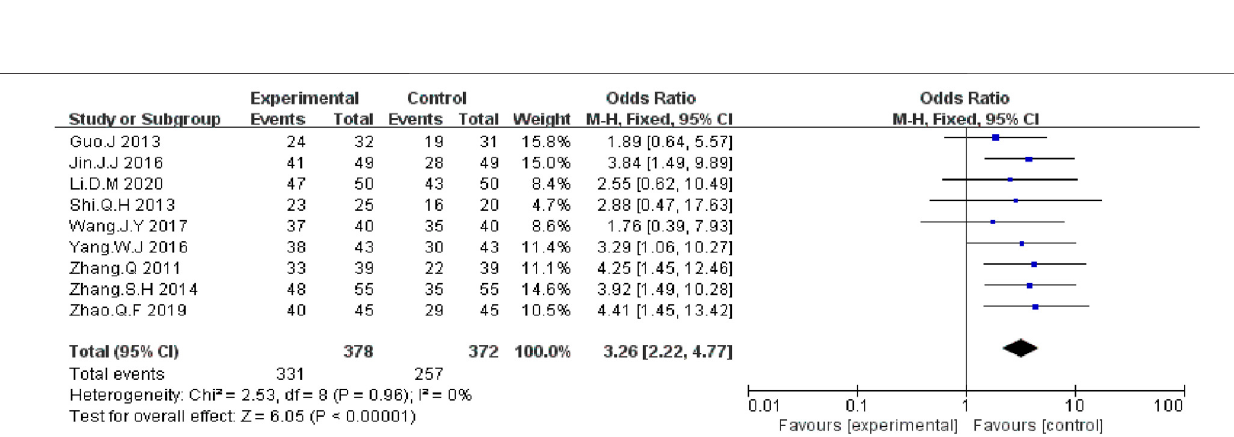
FIGURE 4 | Forest plot of DCR in patients treated with KLT + EGFR-TKI and EGFR-TKI alone.